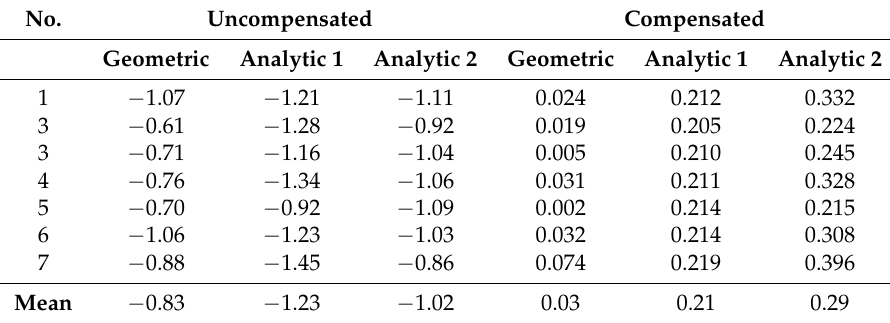
Table 8. The latitude errors for uncompensated and compensated biases (The unit is arcmin).